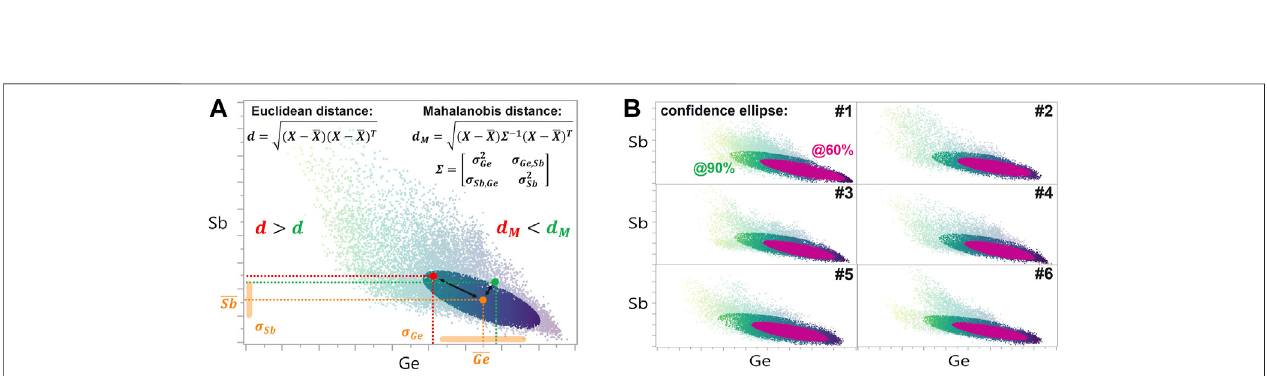
FIGURE3| Chemicalanalysisofdifferentacquisitionsperformedon6areasofthe “ end-of-process ” PCMstackisasfollows:superpositionofsignalmapsofmain elements(Ge+Sb+Tesignals,reportedinred,green,andblue,respectively)isreportedtogetherwiththeircorrespondingSbvs.Gescatterplots.Acquisitionvariability is highlighted.